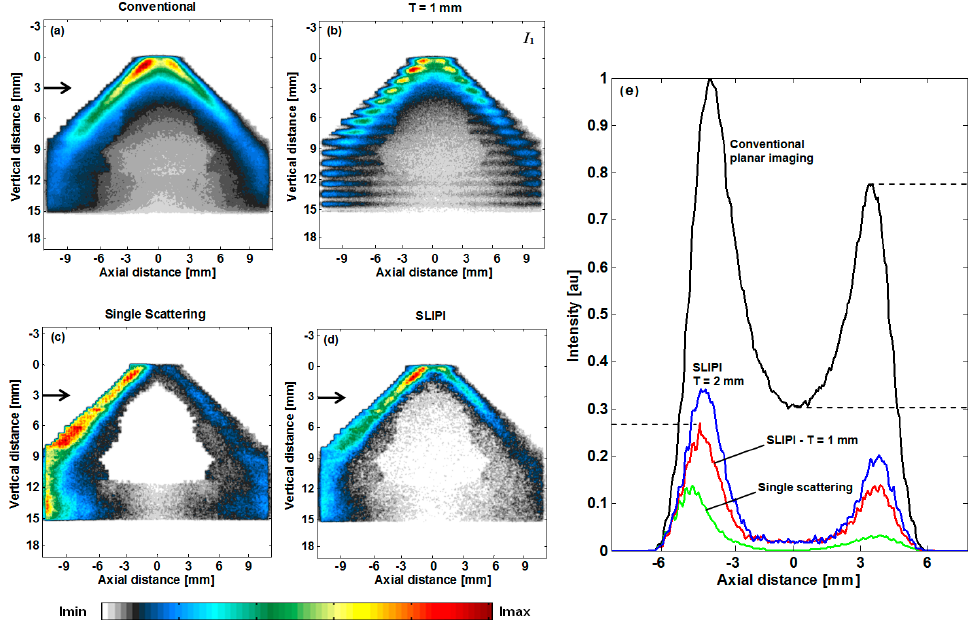
Figure 1. Monte Carlo simulation results from [19] showing a comparison between conventional planar Mie imaging and structured laser illumination planar imaging (SLIPI) for a simulated hollow- cone spray. ( a ) The conventional image; ( b ) the modulated light sheet of T = 1 mm period; ( c ) the single light scattering; and ( d ) the SLIPI images; ( e ) the intensity profiles along the horizontal axis, at 3 mm below the spray orifice. It is observed from the SLIPI image that most of the multiple light scattering is suppressed and that smaller modulation patterns are more efficient in suppressing effects from multiple light